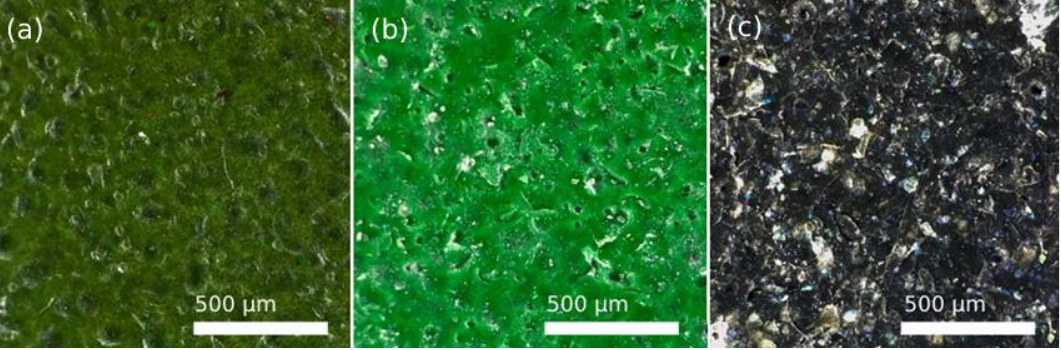
Figure 7. 2D images of the coatings after wear process during 4 s by the projection of glass microspheres at 0.4 MPa, obtained with Leica DVM6 confocal microscope: ( a ) PFA, ( b ) FEP, and ( c ) PTFE.